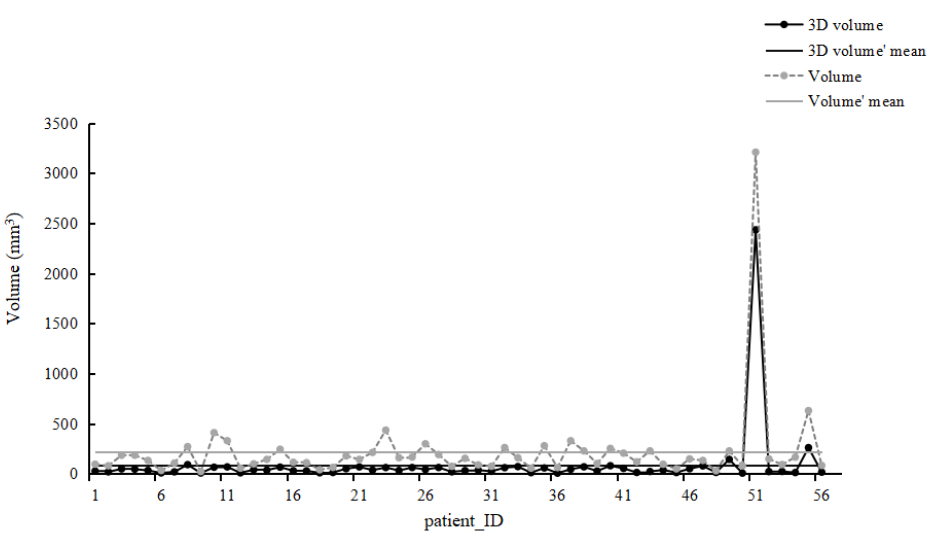
Figure 2. Scatter plots of the two volume measurements. The solid line represents 3D volume, which shows the scatter plot of 56 patients’ 3D semiautomatic volume measurement. The dotted line represents Volume, which shows the scatter plot of 56 patients’ calculated volume using the longest diameter.